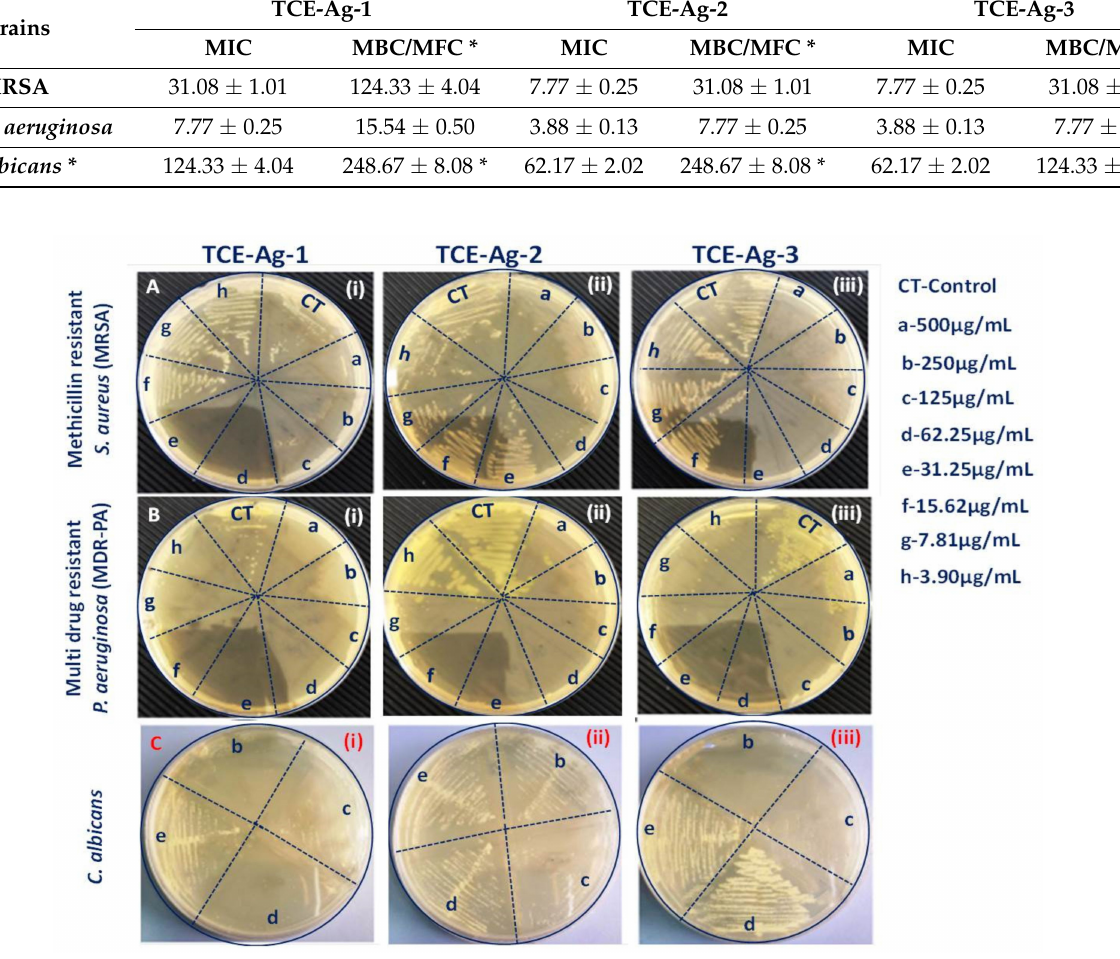
Figure 7. Comparative determination of MIC, MBC, and MFC values of TCE-Ag-1, TCE-Ag-2, and TCE-Ag-3 NPs against MDR-PA, MRSA, and C. albicans